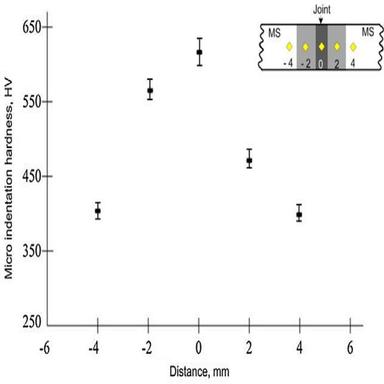
Micro indentation hardness variation in joint zone at both sides of the centre of the joint.